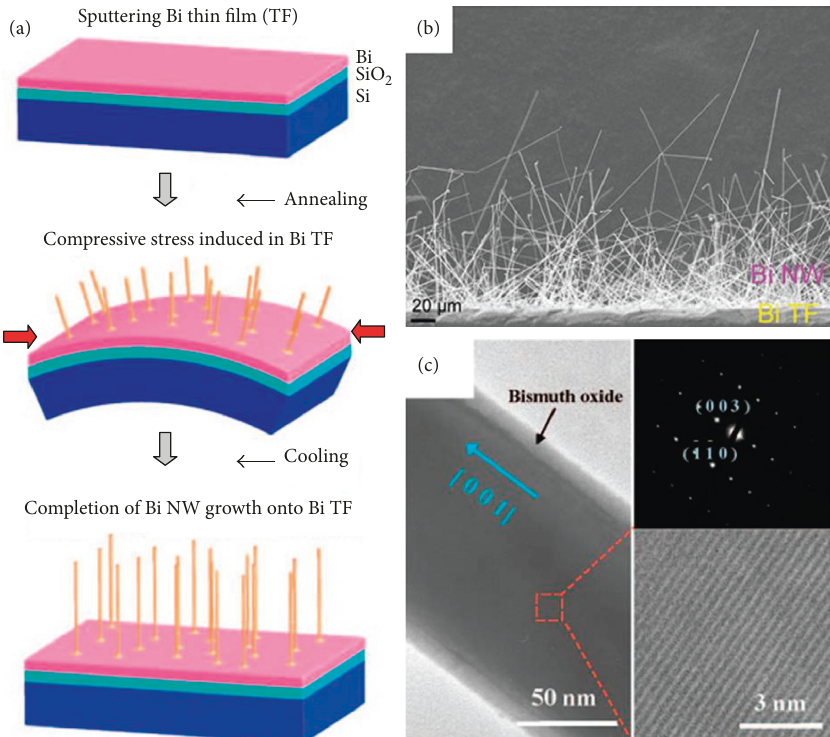
Figure 5: (a) Schematic representation of the growth mechanism by the OFF-ON method. (b) SEM image of the grown Bi nanowires. (c) Transmission electron microscope (TEM) image of a Bi nanowire and its electron diffraction patterns and crystal structure [27]. Reprinted with permission from American Chemical